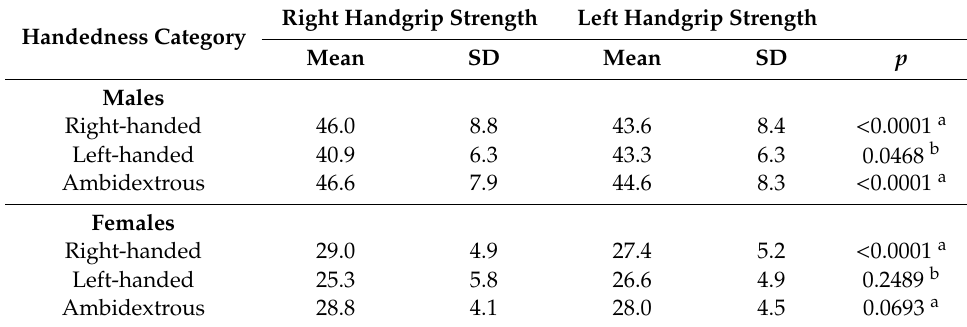
Table 3. Comparison between sides in handgrip strength for each handedness category by sex. Handedness